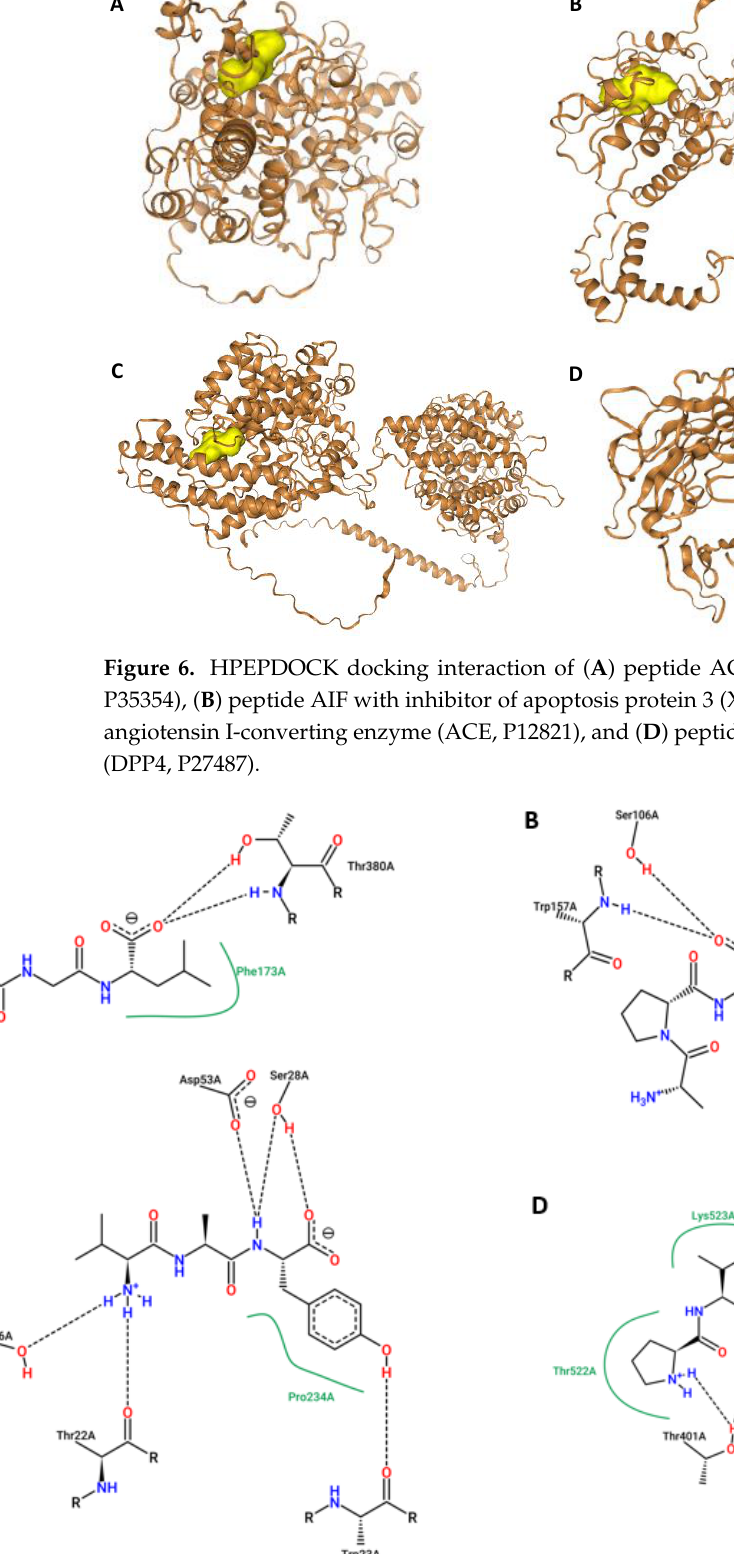
Figure 7. PoseView of AutoDock vina docking interaction of ( A ) AGL and cyclooxygenase-2 (PTGS2, P35354), ( B ) APL and dipeptidyl peptidase IV (DPP4, P27487), ( C ) VAY and HLA class I histocompatibility antigen A-3 (HLA-A, P04439), and ( D ) PVI and dipeptidyl peptidase IV (DPP4, P27487).